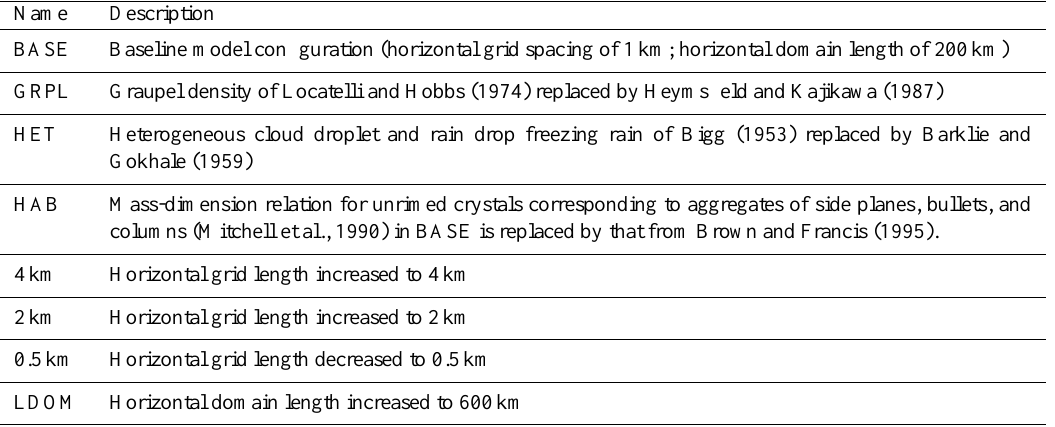
Table 3. List of the ensemble sensitivity tests described in Sect.